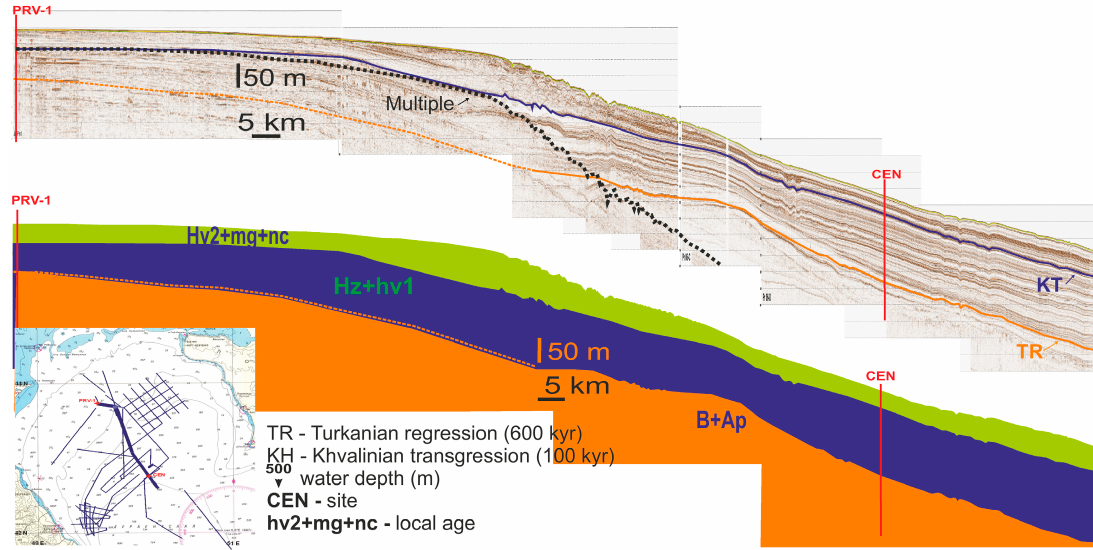
Figure 3. Middle Caspian sparker data and stratigraphy scheme. Regional unconformities: TR— Turkanian regression (600 kyr), KH—Khvalinian transgression (100 kyr). Local age: B + Ap—Bakinian and Apsheron transgressions, Hz+Hv1—Khazar and Khvalinian (first step) transgressions, hv2 + mg + nc—Khvalinian (second step) transgression, Mangyshlak regression (7–10 kyr) and new-Caspian transgression. CEN—Site Centralnaya. PRV-1—Site PRV-1.